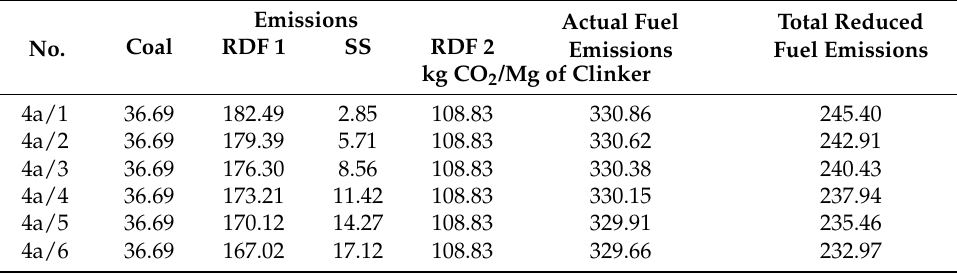
Table 9. The CO 2 emissions balance of blends of coal with RDF 1-RDF 2-SS (4a—four components).